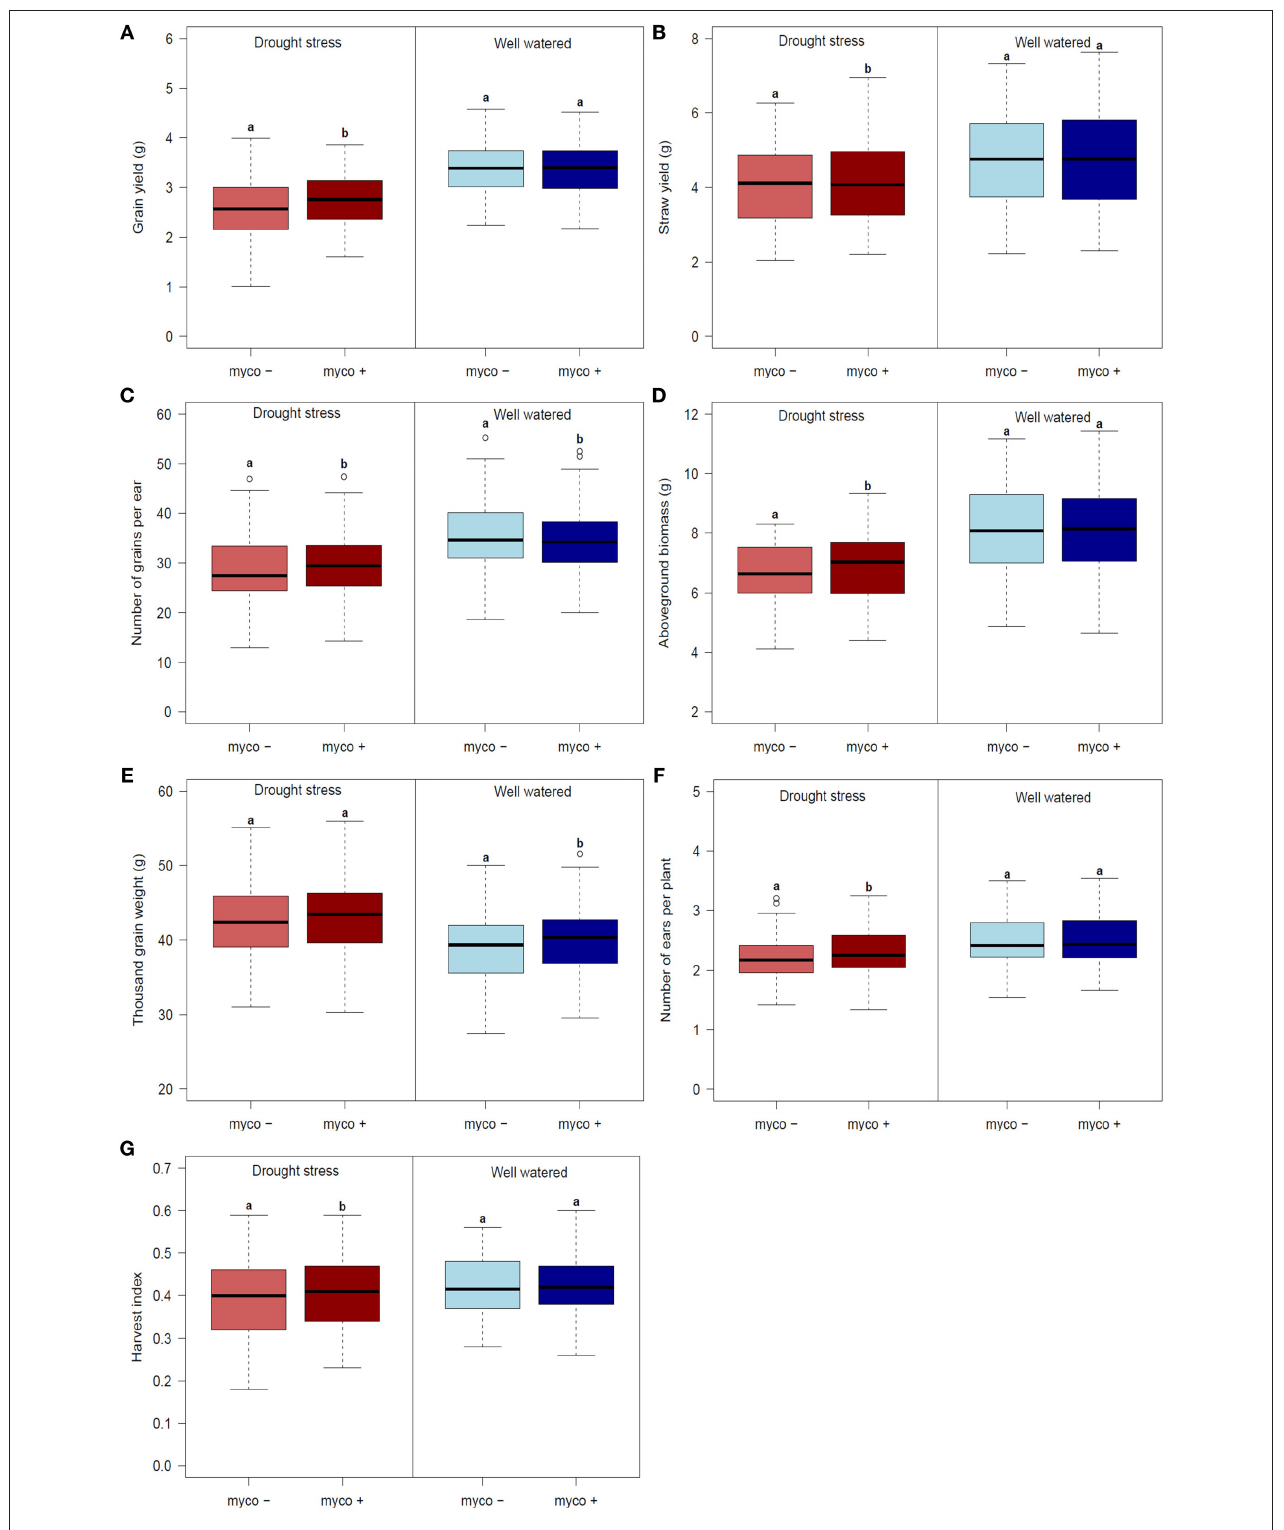
FIGURE 2 | Boxplots of genotype means for (A) grain yield (GY), (B) straw yield (SY), (C) number of grain per ear (GN), (D) aboveground biomass (BM), (E) thousand grain weight (TGW), (F) harvest index (HI) and (G) number of ears per plant (EN) for 94 genotypes under drought stress (left) and well watered (right) conditions in the presence (myco + ) and absence (myco − ) of mycorrhizae evaluated in 2 years. Means of the mycorrhizal and non-mycorrhizal treatment followed by the same letter under drought stress or well watered conditions, respectively, are not significantly different at the 5% ( α = 0.05) level.